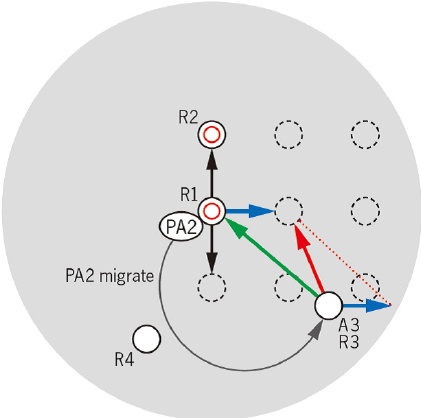
Fig. 6. A1 generates a pheromone agent and attracts A3 with its robot